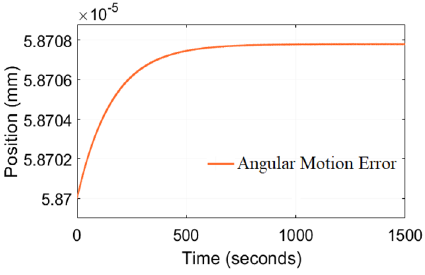
Fig. 8 PID Controller result for parameters obtained with GA for swinging/angular motion of overhead crane